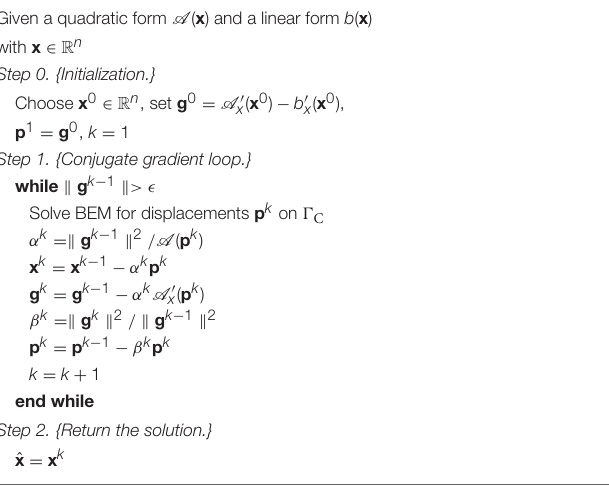
TABLE 1 | ( M1 ) Conjugate gradient method (CG) adapted for EC–BEM. Given a quadratic form A ( x ) and a linear form b ( x ) with x ∈ R n